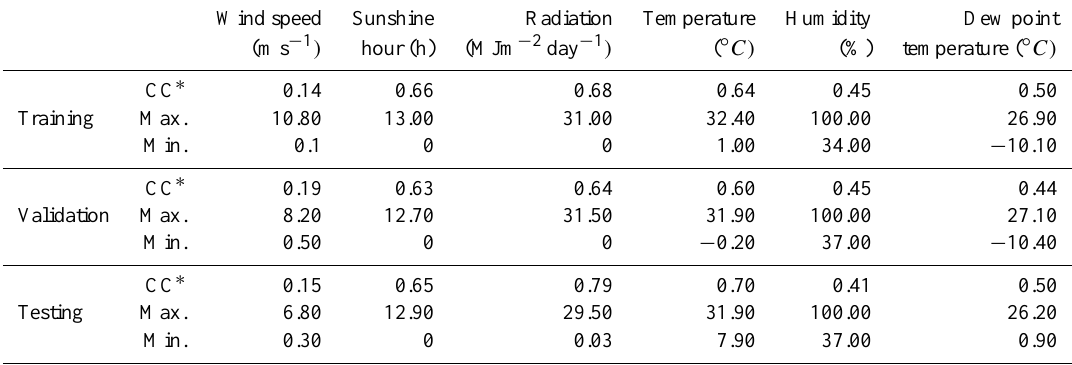
Table 1. Statistics of meteorological variables in training, validation and test subsets.